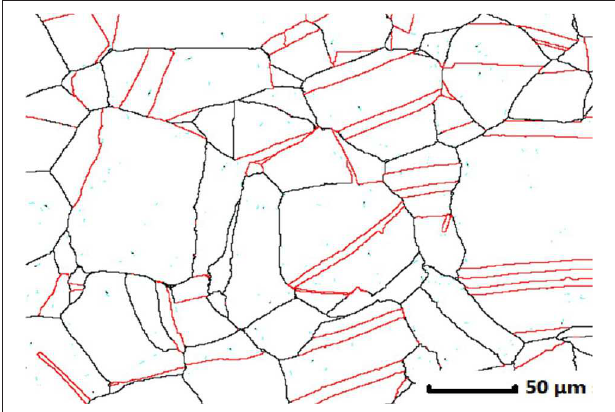
FIGURE 1 | Microstructure of annealed specimen. The high angle and 6 -twin boundaries are shown as black and red lines, respectively.